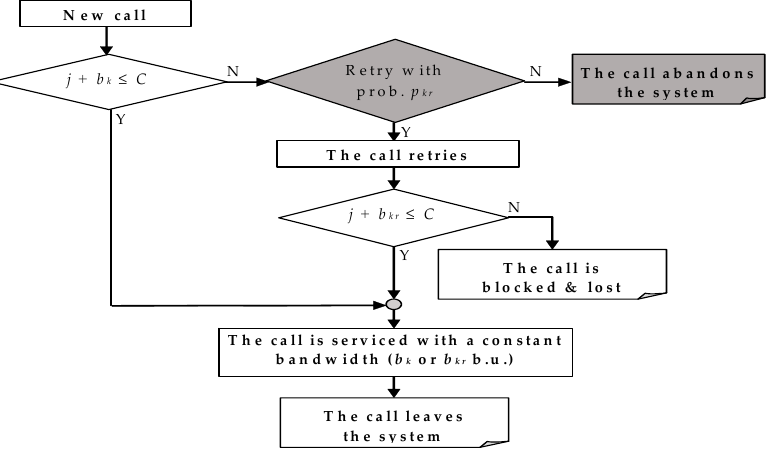
Figure 1. The call admission mechanism for a new call in the probabilistic retry loss model. In order to derive (1), we assume that: (1) Local balance exists between adjacent states, which is correct in models whose steady state probabilities have a PFS and (2) retry calls do not exist in the link (i.e., the occupied link bandwidth from such calls is considered to be negligible) when the link occupancy j does not exceed the retry boundary, i.e., when j ≤ C − ( b k − b kr ). The second assumption is expressed in (1) via γ k ( j ) . Having computed, via (1), the unnormalized values of q ( j )’s, we can now calculate the CBP of service-class k calls with their reduced bandwidth requirement of b kr b.u., B kr